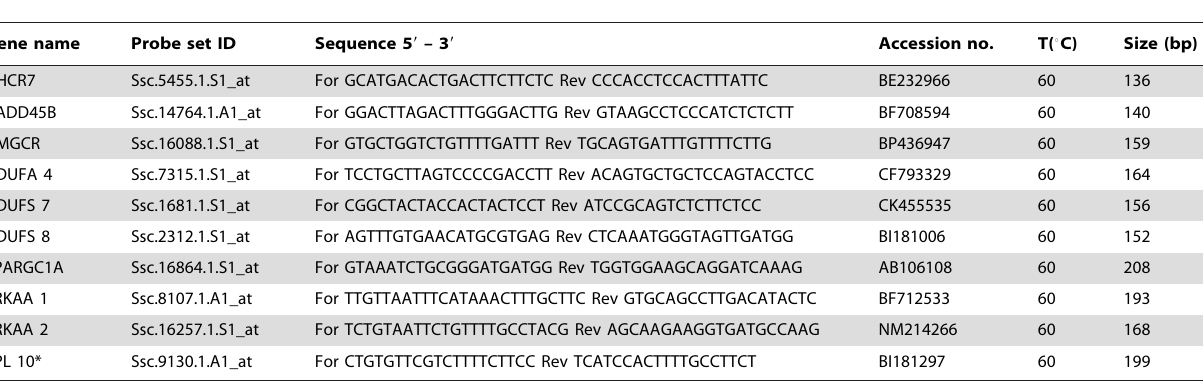
Table 4. Primer used to verify microarray experiments in liver tissue by